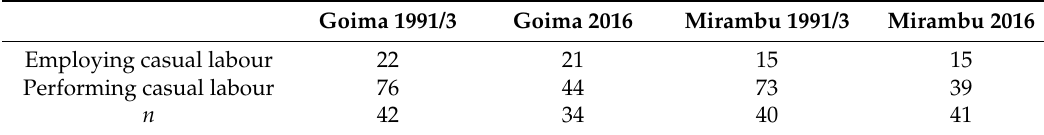
Table 8. Casual Work Goima and Mirambu villages (proportion of sample).